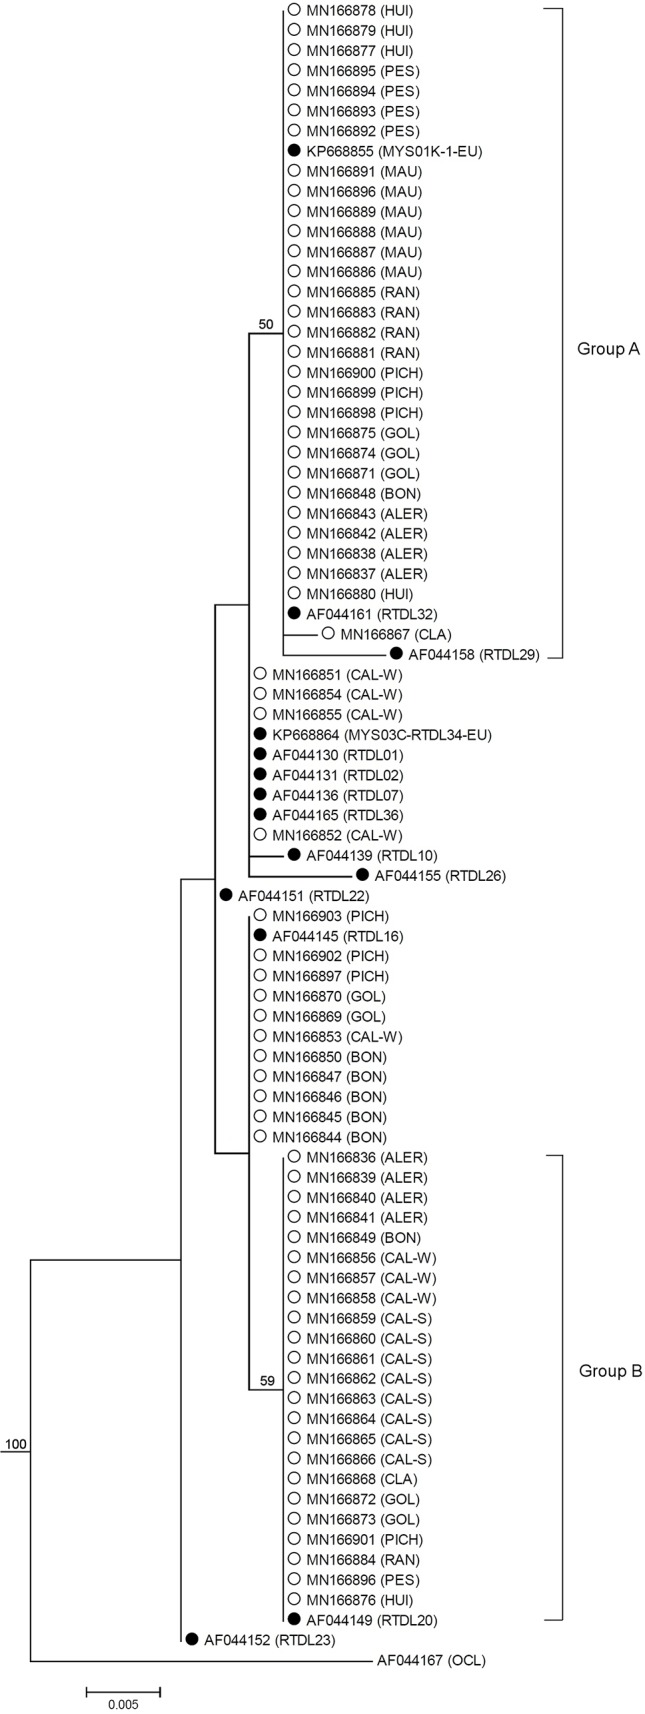
Maximum likelihood consensus tree for Chilean naturalized rainbow trout populations based on the mtDNA control region. Samples analyzed in this study (white circles) are indicated by the Genbank accession numbers and population code are in parenthesis. Reference haplotypes (black circles) are indicated by the Genbank accession numbers, while the haplotype labels for native ecotypes are in parenthesis. Haplotype labels for native ecotypes correspond to those indicated in
Supplementary Table 1
. The values on the nodes indicate the bootstrap support for each node; values >50% are shown. The branch lengths are drawn proportional to the relative amount of evolutionary change. Scale indicates the sequence divergence estimated from the number of nucleotide substitutions per site.